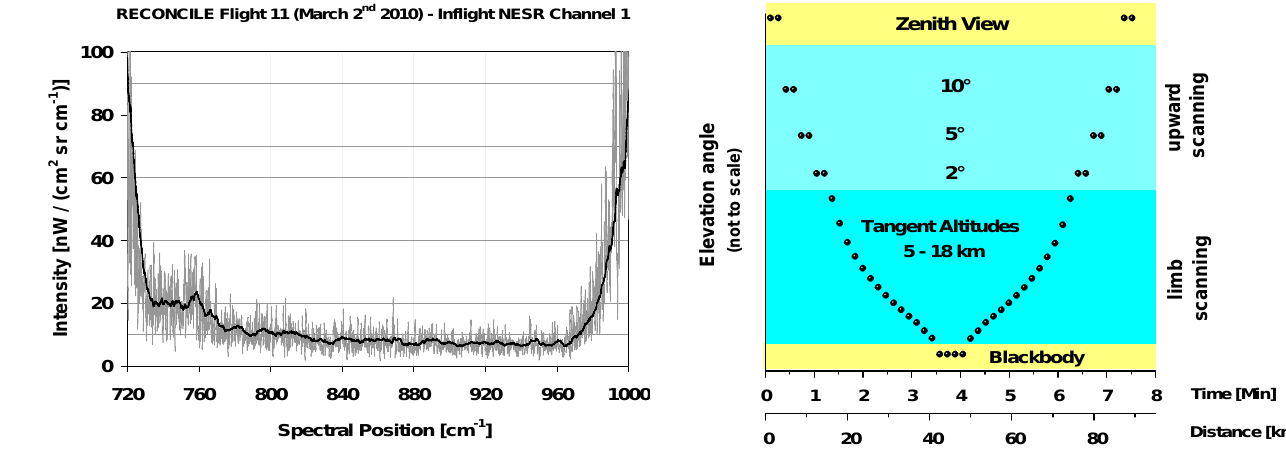
Fig. 3. Schematic representation of the standard sampling pro- gramme of MIPAS-STR, including atmospheric measurements (cyan) and calibration measurements (yellow). Two full limb scans are